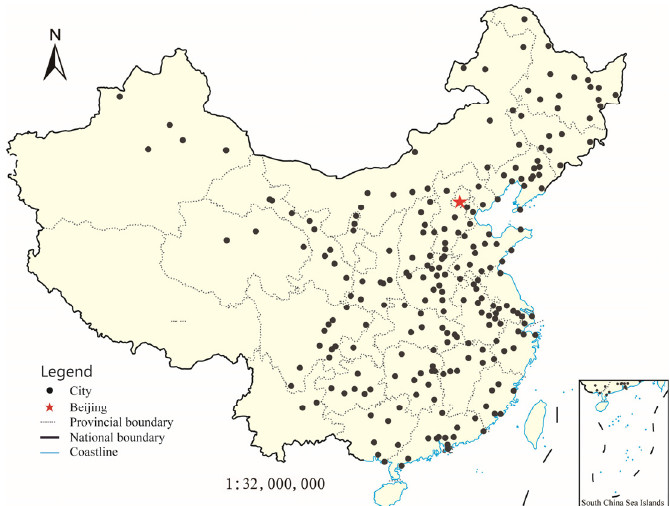
Figure 2. Beijing and the 226 cities selected in the research.